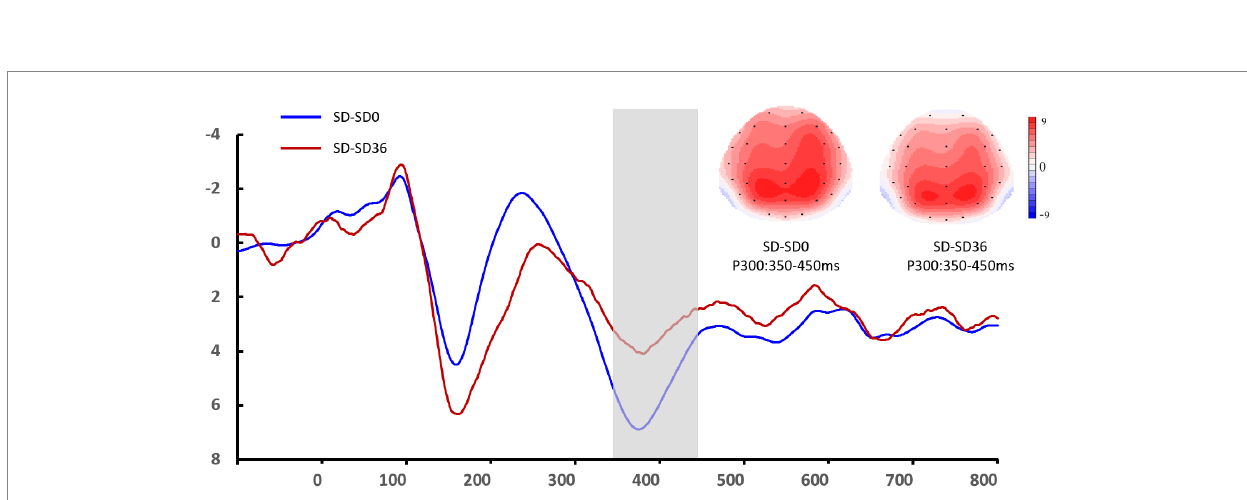
FIGURE 6 Grand mean amplitude of the P3 component in the sleep deprivation (SD) group after 0 h of sleep deprivation (SD0) and 36 h of sleep deprivation (SD36). Averaged data from the F3, Fz, F4, C3, Cz, C4, P3, Pz, and P4 electrodes are shown. The topographies correspond to average activity in the time windows (350–450 ms, indicated by the gray bar) around the local